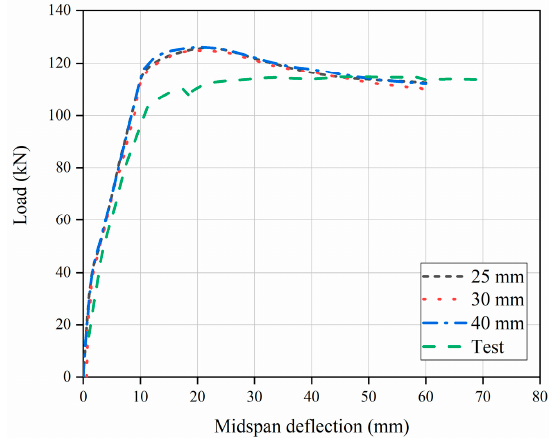
Figure 4. Mesh size effect of specimen C30R50F1.